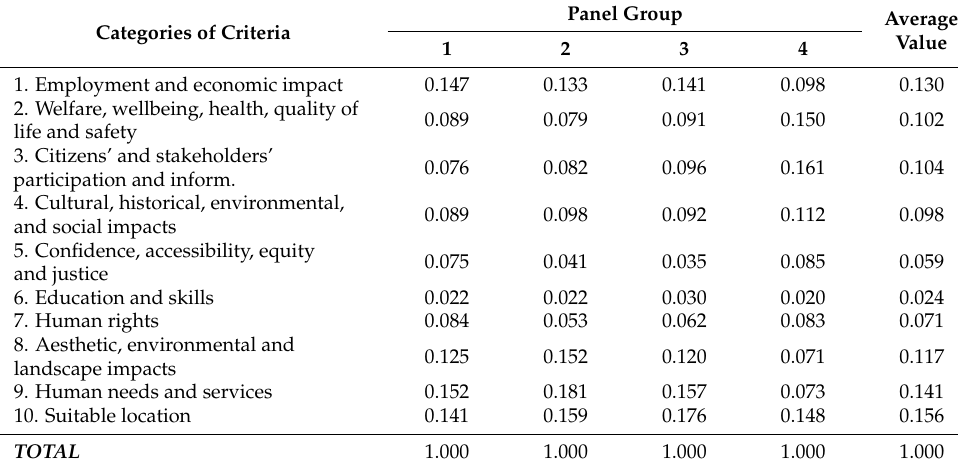
Table 5. Weights of social criterion categories by Panel group.